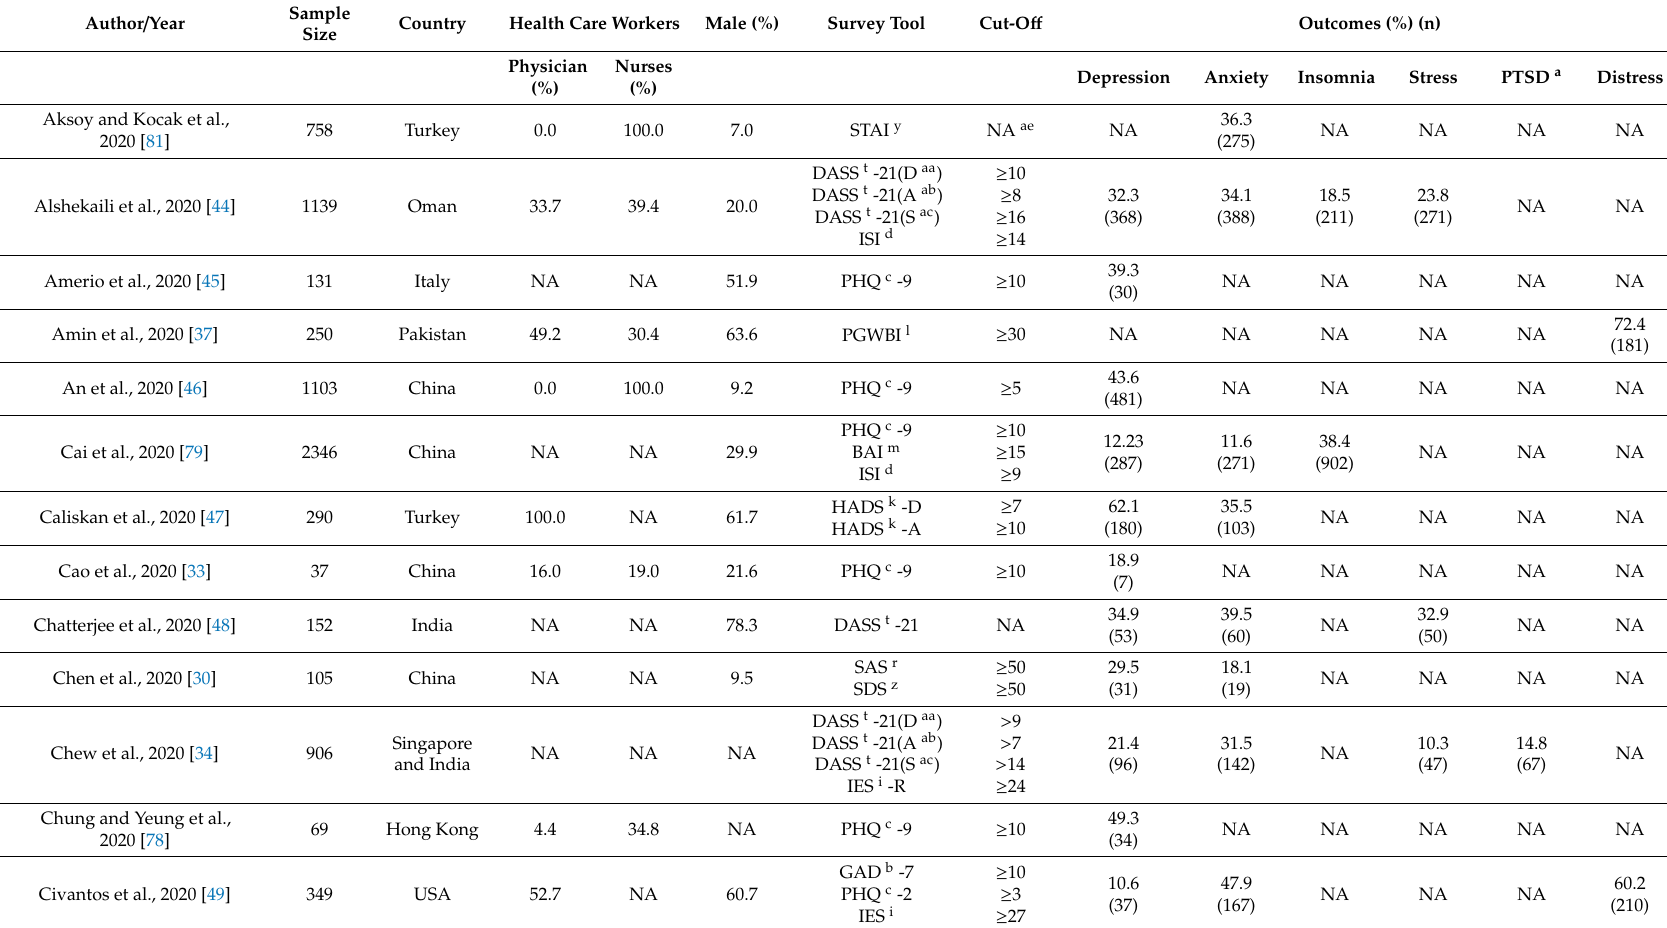
Table A3. Characteristics of studies meeting the search inclusion